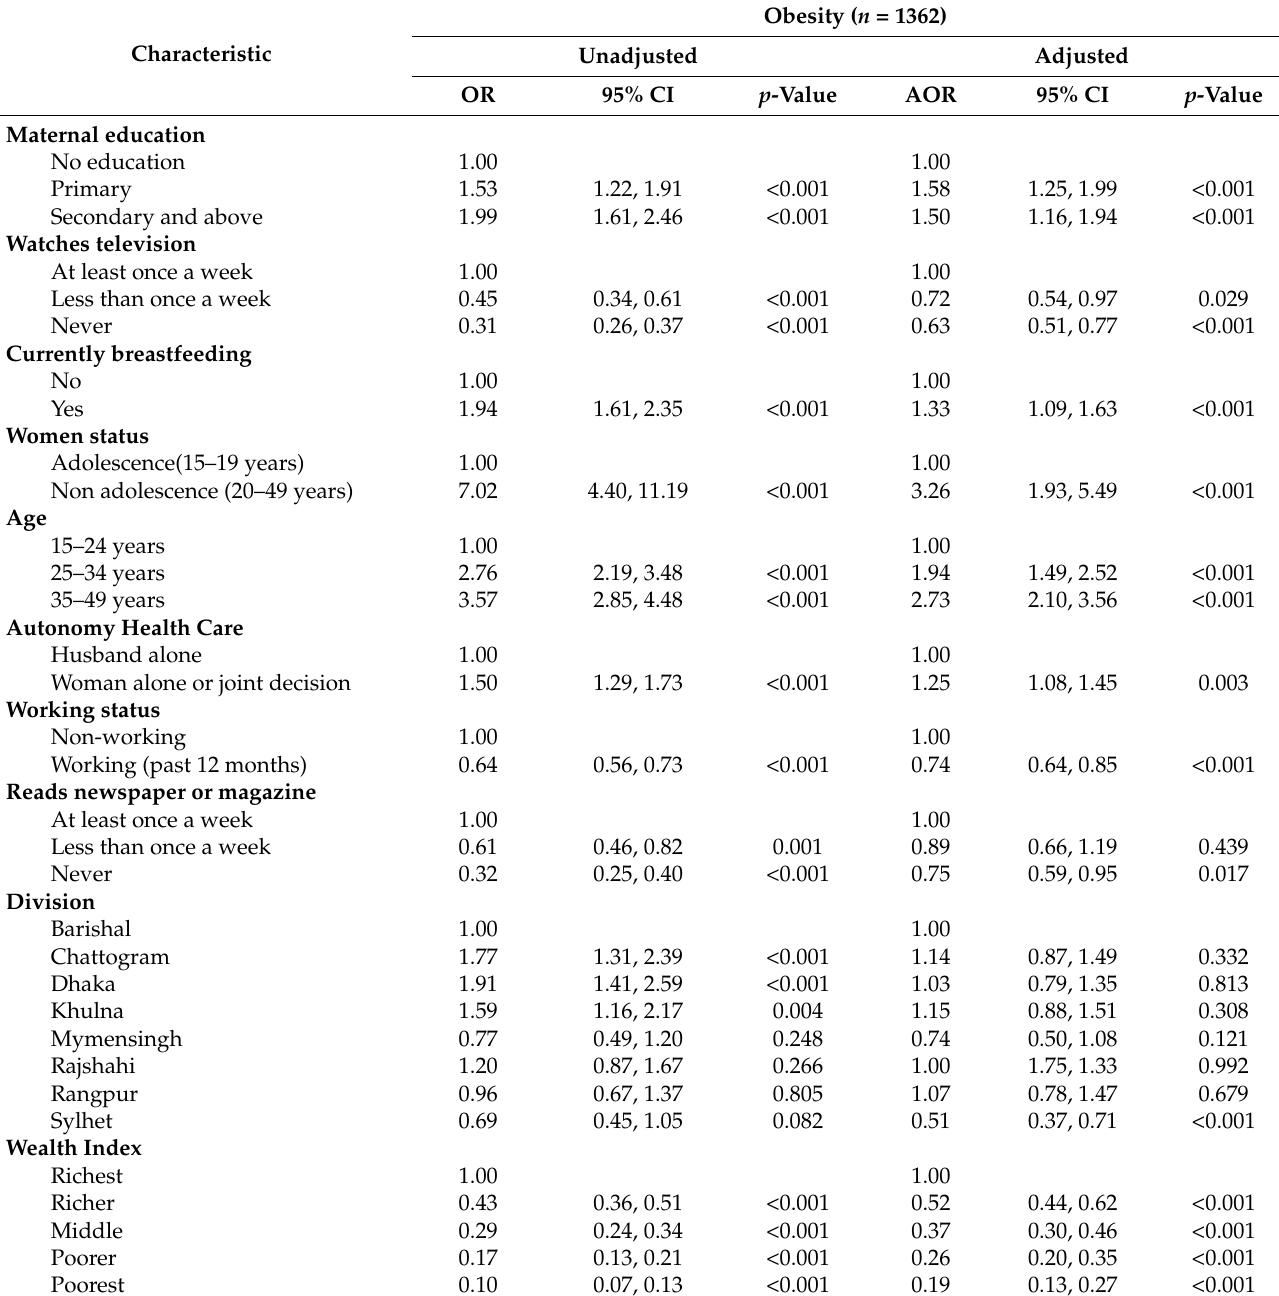
Table 4. Survey logistic modeling of reproductive-age women being obese: unadjusted (OR) and adjusted Odds Ratios (aOR), Bangladesh